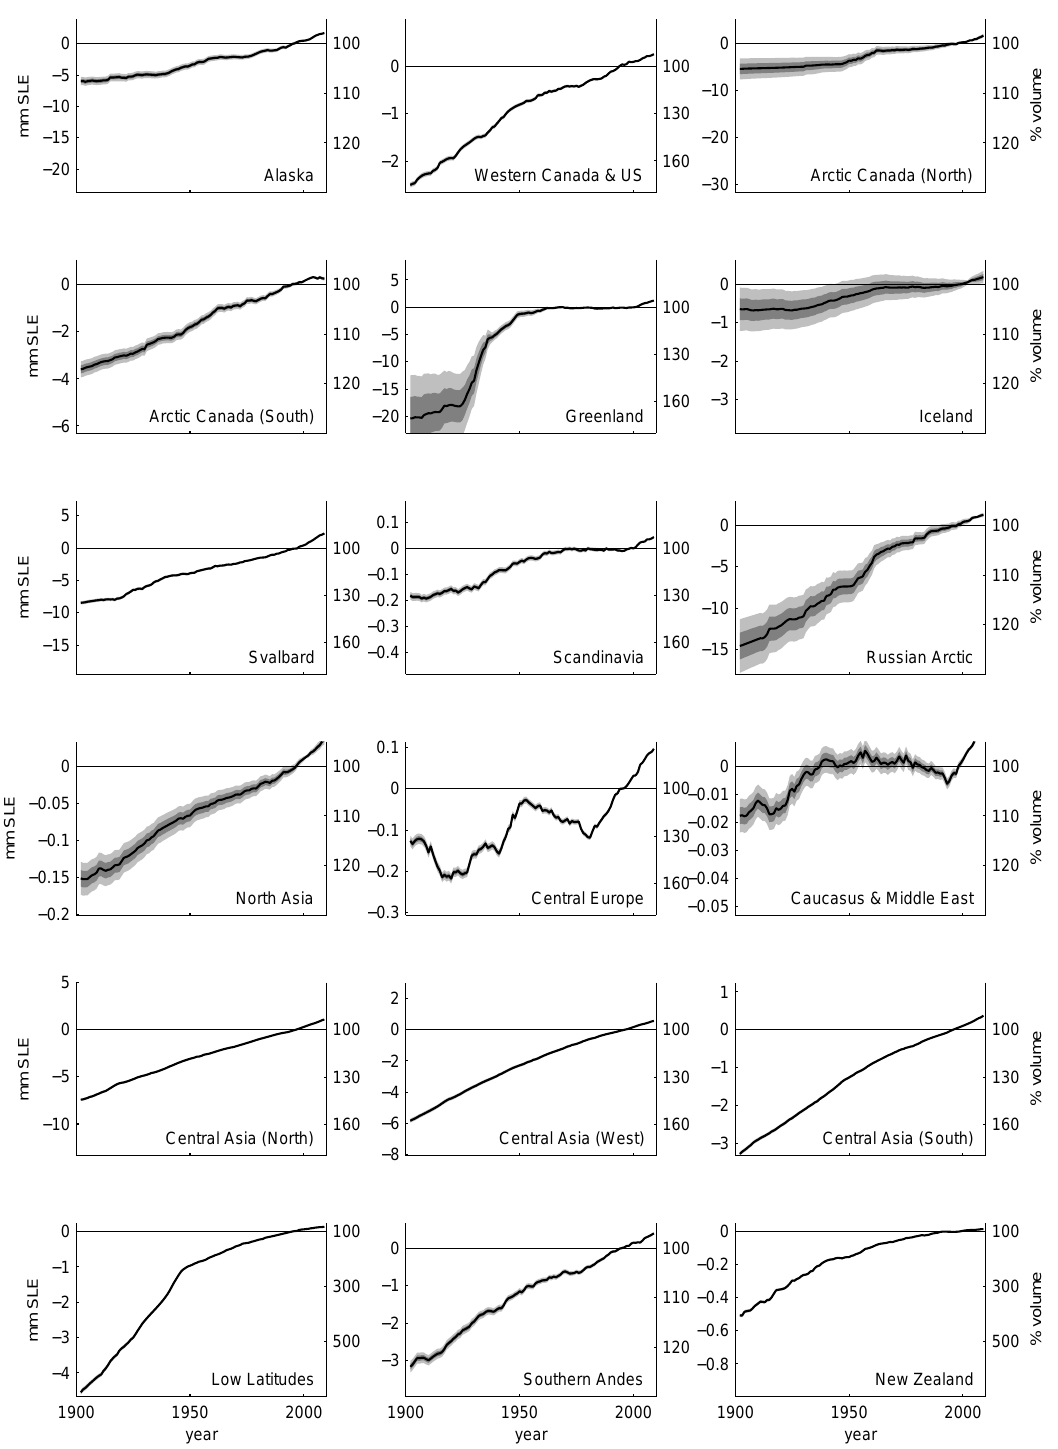
Fig. 17. Cumulative regional surface mass balances (black line) relative to the 1986–2005 mean, and standard errors (light gray shading: two standard errors; dark gray shading: one standard error), from the CRU-forced